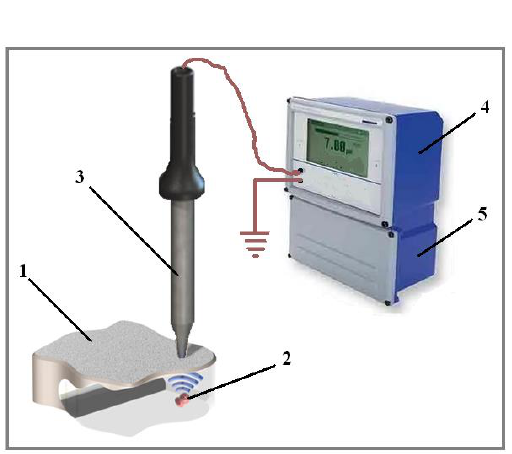
Figure 1.Signal measurement in electrophysical method: 1 –studied sample; 2-defect 3-sensor or transducer; 4-Measuring device (multimeter); 5- computer.